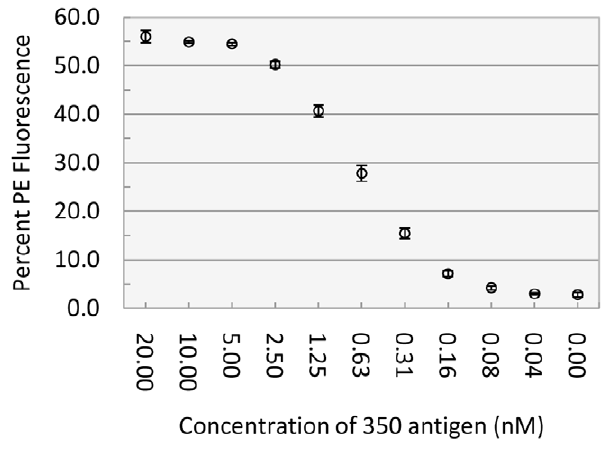
Figure 3. Lower limit of detection of 350 antigen by lyophilized yeast-scFv clone 350-E2 . Lyophilized 350-E2 yeast cells were reconstituted in 1 mL YWB and split into 11 equal aliquots. Each aliquot was incubated with 10 concentrations of 350-biotin antigen ranging from 20 nM to 0.04 nM (plus the 0 nM control) in twofold serial dilutions in 2.5 mL (total volume) YWB. Bound 350 antigen was detected by incubating with a rabbit anti-350 antiserum followed by goat-anti-rabbit-phycoerythrin (GaR-PE) detection. Samples were ana- lyzed by flow cytometry. The entire experiment was repeated three independent times, and each replicate was performed with an individually grown, induced, and lyophilized 350-E2 clone. Each data point shows the average mean percent PE-positive yeast plus and minus the standard deviation.